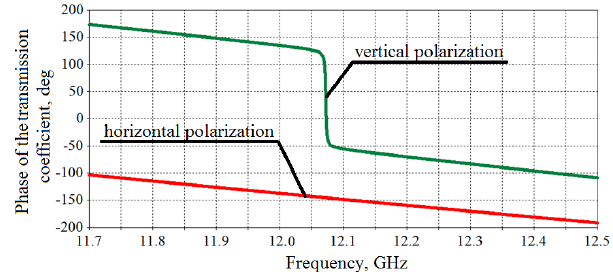
FIGURE 7. Dependences of phase of the reflection coefficient on frequency for horizontal and vertical polarizations calculated by the numerical model.